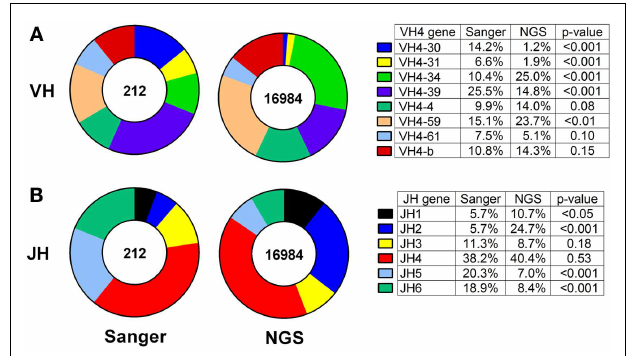
FIGURE 1 | VH4 gene distributions show cross-platform variation for samples from both patients with RRMS and CIS . VH4 (A) and JH (B) gene calls were obtained by IMGT alignment.Total sequences used in Sanger sequencing and next-generation sequencing (NGS) databases are indicated inside the pie charts. Statistically significant differences between the frequencies of individual genes were identified by Chi-squared test ( p -value: N.S. ≥ 0.05).